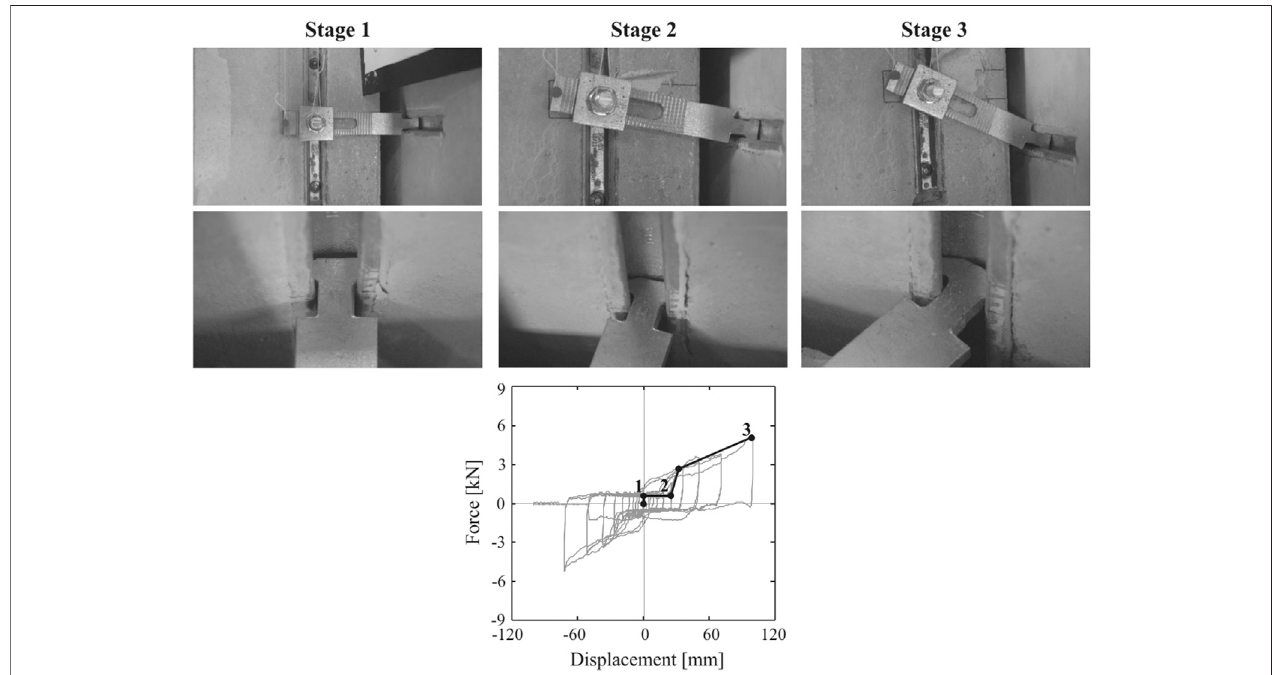
FIGURE 7 | Failure mechanism of the investigated connections, adopted from Zoubek et al. (2016a).